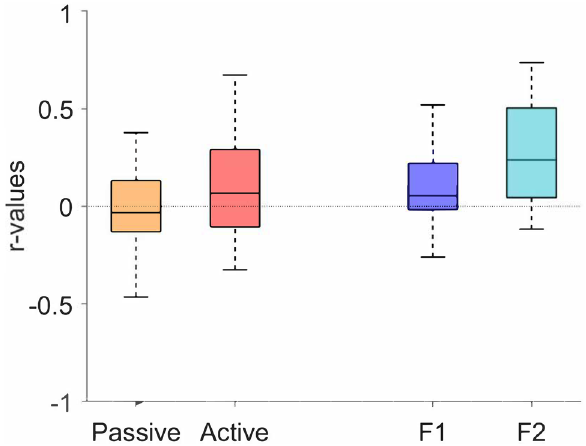
Figure 3. Correlations between cardiogram-actogram. Depicted are the median (central mark), and the 25th and 75th percentile (bottom and top edges of the box, respectively).